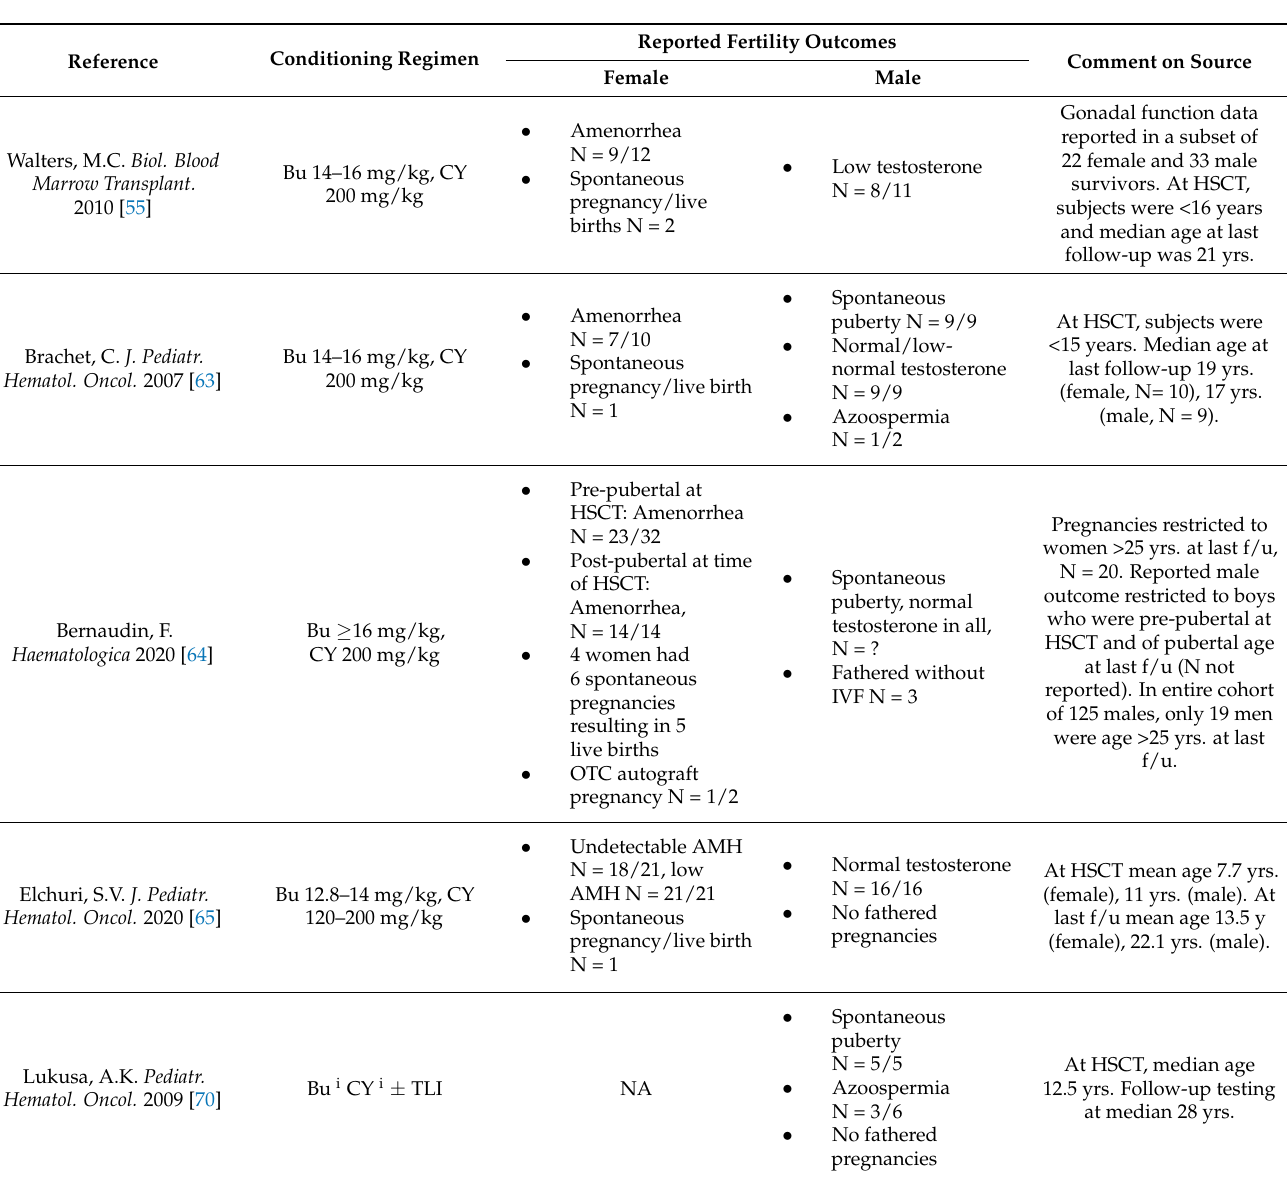
Table 3. Summary of published fertility outcomes among patients with SCD after HSCT highlights the challenges in drawing definitive conclusion about fertility from existing reports. Methodological challenges include differences of pubertal stage at HSCT and variable HSCT-follow-up times, lack of pre-HSCT data, differences in reported outcomes, and lack of report of pregnancy attempts and/or infertility diagnoses. Data collection and reporting may be improved with adherence to the NHLBI’s new Cure Sickle Cell Initiative guidance on pre- and post-hSCT data